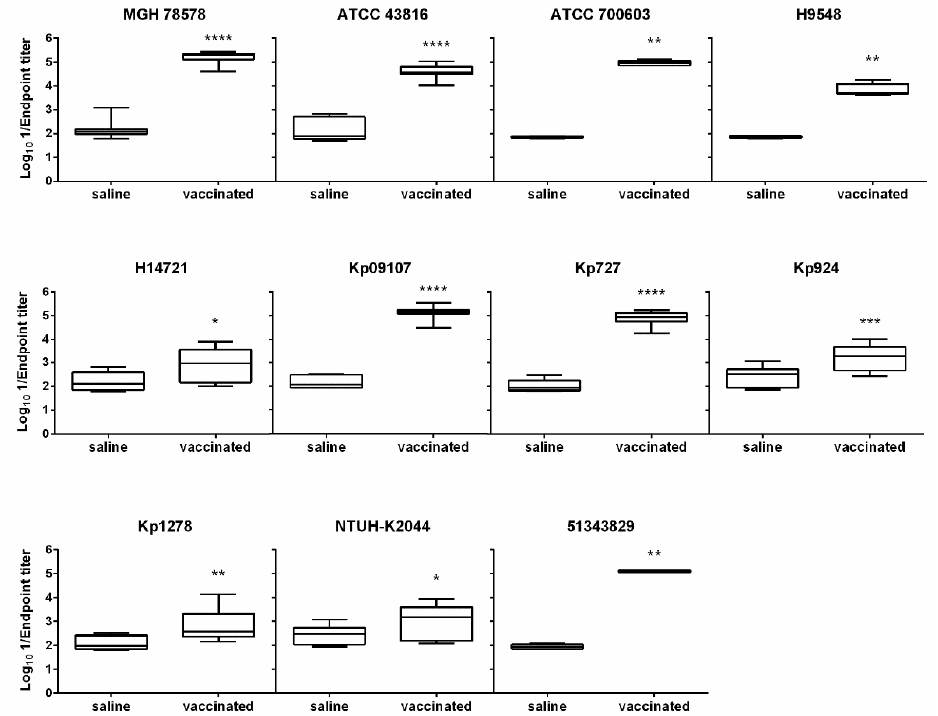
Figure 5. Inoculation with the D-glutamate auxotrophic vaccine elicited cross-reactive antibodies. Cross-reactivity (Log 10 1/Endpoint titer) of IgG antibodies produced by BALB/c mice ( n = 6–12) on day 21 post-inoculation and in uninoculated control mice against the parental strain MGH 78578 and ten different Klebsiella spp. heterologous strains was observed. The antibody titers were determined by indirect ELISA. * p < 0.05, ** p < 0.01, *** p < 0.001 and **** p < 0.0001 relative to the group of uninoculated mice (Mann–Whitney U test) .